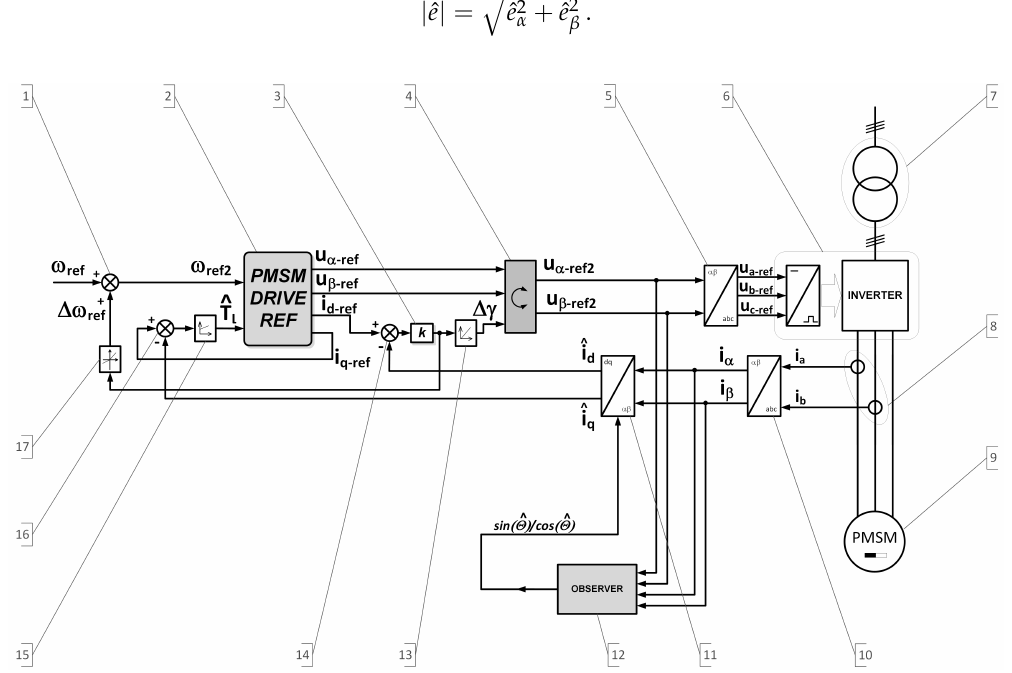
Figure 2. Control structure for the low-speed